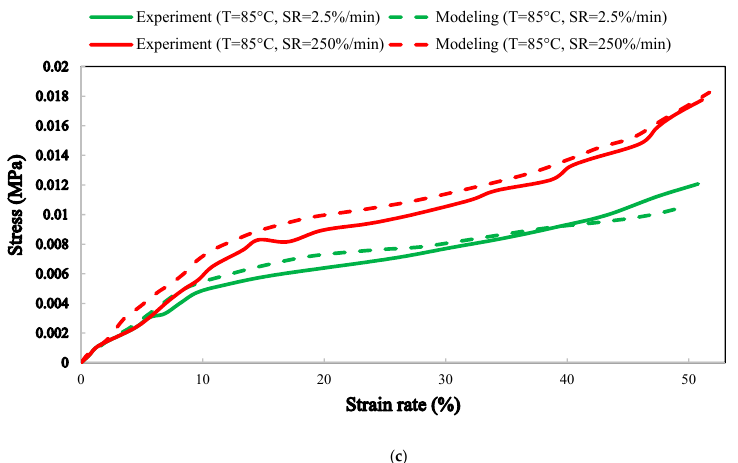
Figure 12. Comparison of numerical and experimental stress-strain curves of PU foams at different temperatures and strain rates (SR=2.5 and SR=250%/min): ( a ) T=28 ℃ , ( b ) T=55 ℃ , and ( c ) T=85 ℃ .